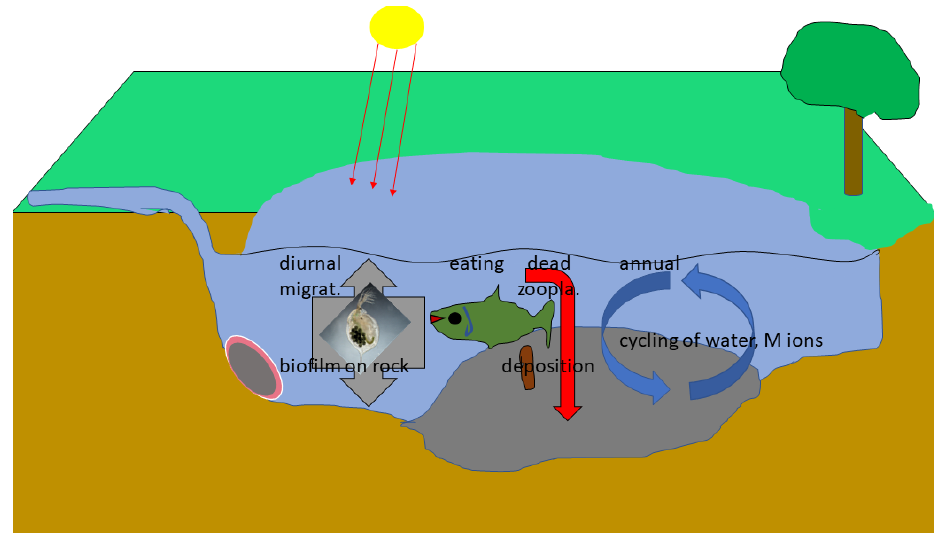
Figure 11. Different polysaccharides are involved in retention of M ions in limnetic environments, including biofilms (mainly glucan, left) and chitin actively (diurnal migration of copepods and water fleas) and passively (deposition of dead arthropods), switching among water depth levels. Upon illumination along appropriate organic matter, Eu—hitherto firmly adsorbed to chitin to an exceptional extent—photooxidizes the latter by CH bond photocleavage. Transport by animal movement (cp. Figures 1 and 2) competes well with that caused by annual circulation.